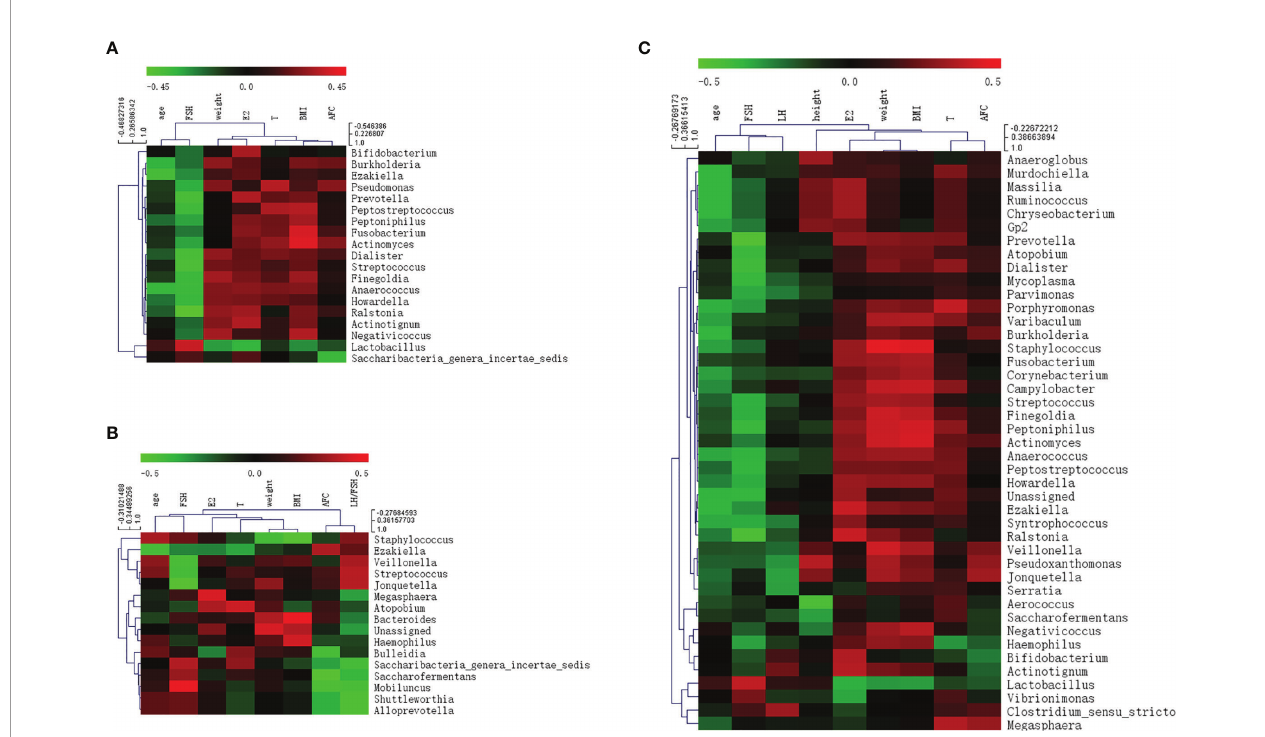
FIGURE 6 | Heat map of Pearson correlation coef fi cient between vaginal microbiome and environmental factors. (A) Pearson correlation coef fi cient heat map between vaginal microbiome and environmental factors in total samples; (B) Pearson correlation coef fi cient heat map between vaginal microbiome and environmental factors in control samples; (C) Pearson correlation coef fi cient heat map between vaginal microbiome and environmental factors in polycystic ovary syndrome